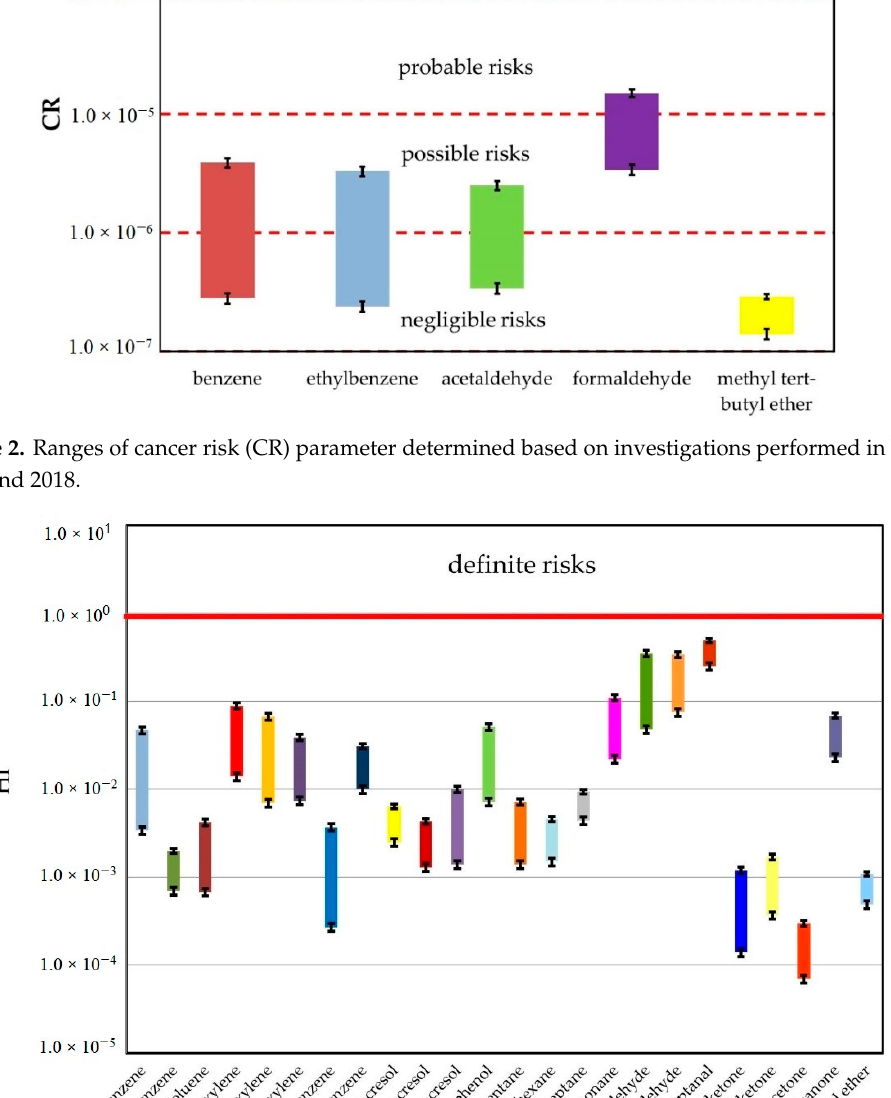
Figure 2. Ranges of cancer risk (CR) parameter determined based on investigations performed in both 2017 and 2018.